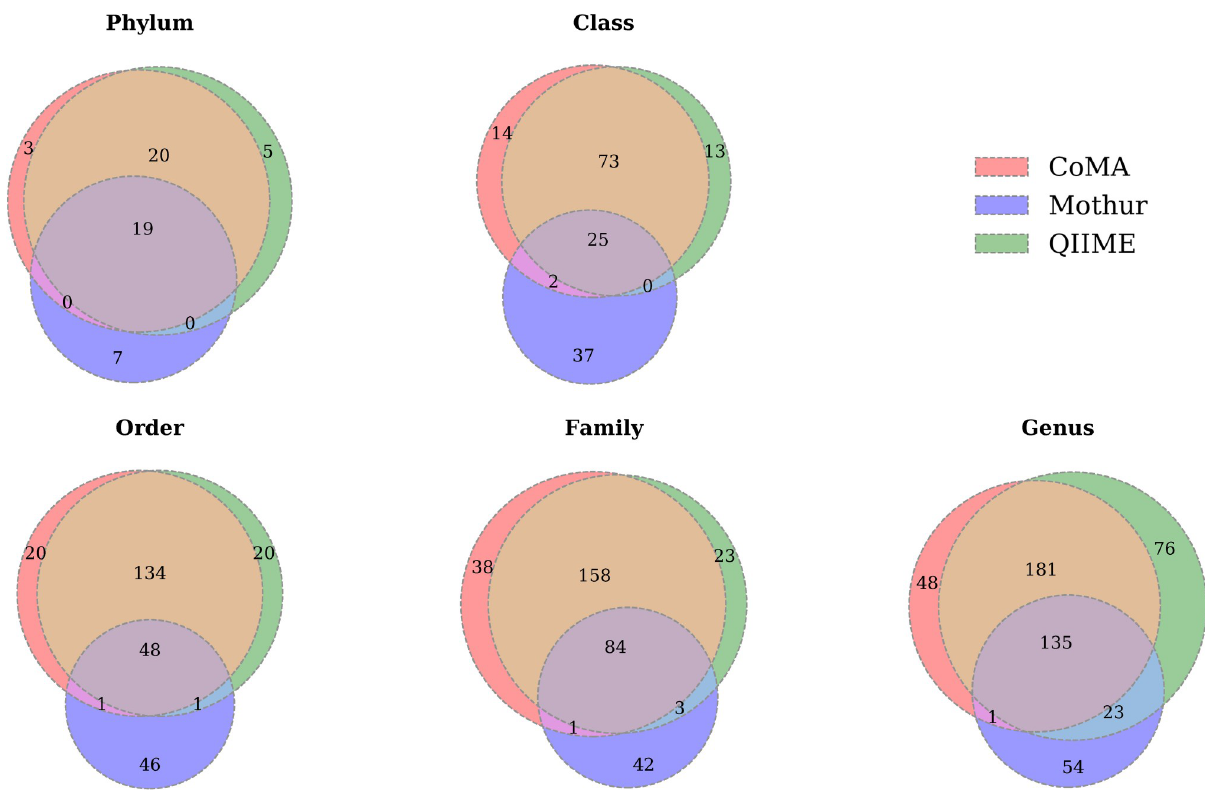
Fig 7. Venn plots showing the shared phyla, classes, orders, families and genera found with CoMA, Mothur and QIIME in the soil samples. Data include all of the three investigated habitats (forest, grassland, swamp).